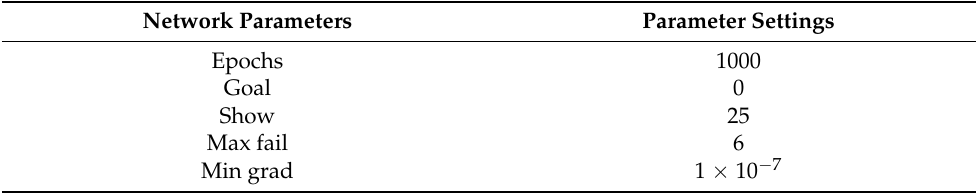
Table 6. BP neural network model parameter